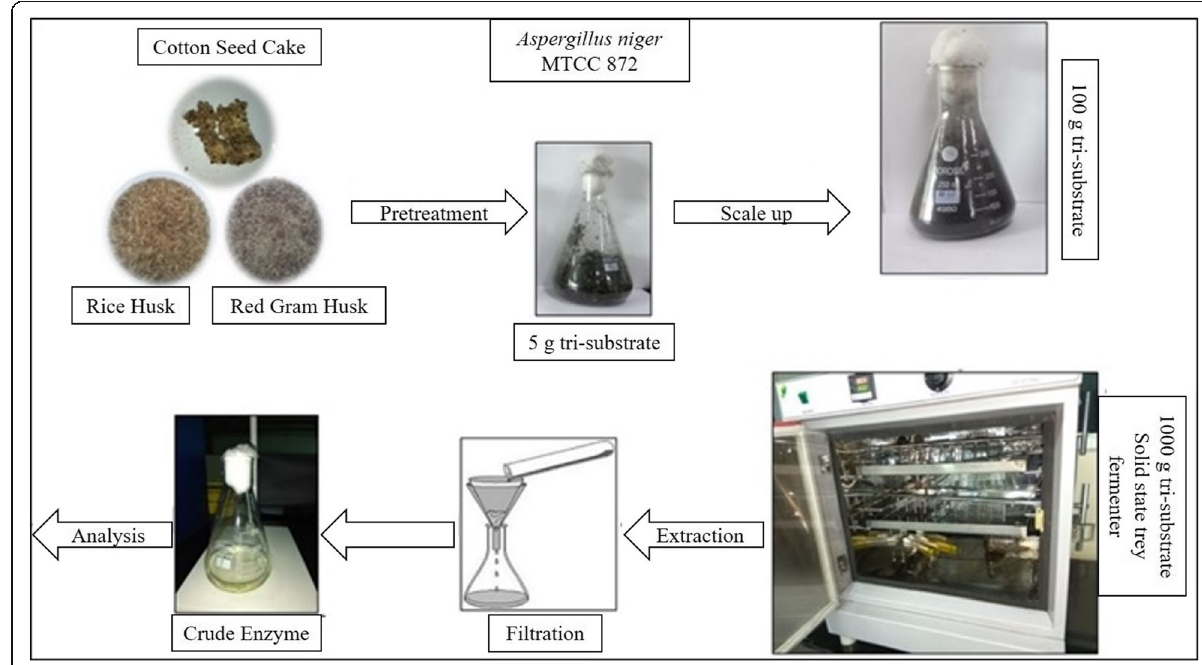
Fig. 1 Graphical abstract of lipase production using solid-state fermentation with Aspergillus niger MTCC